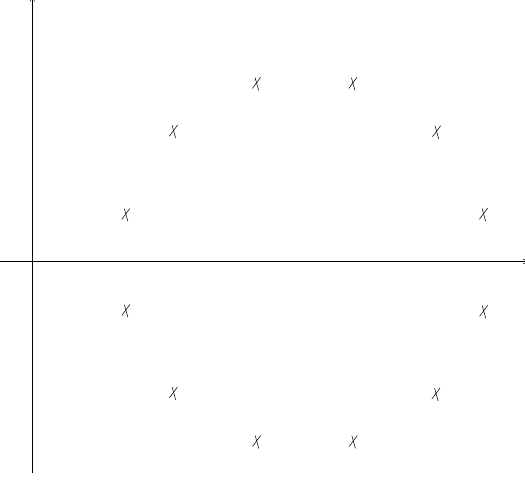
Figure 2 . Illustration of structure of rami(cid:12)cation map; the crosses denote A i